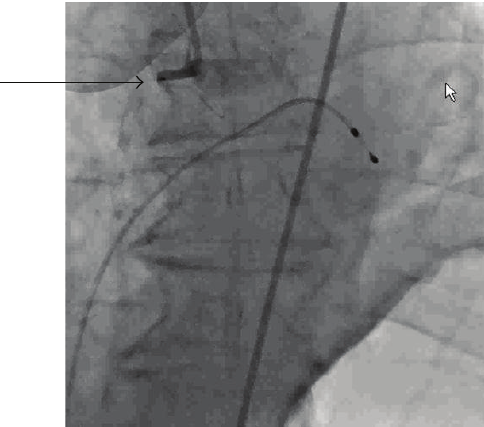
Figure 3: RCA revealing 100% thrombosis of the recently placed